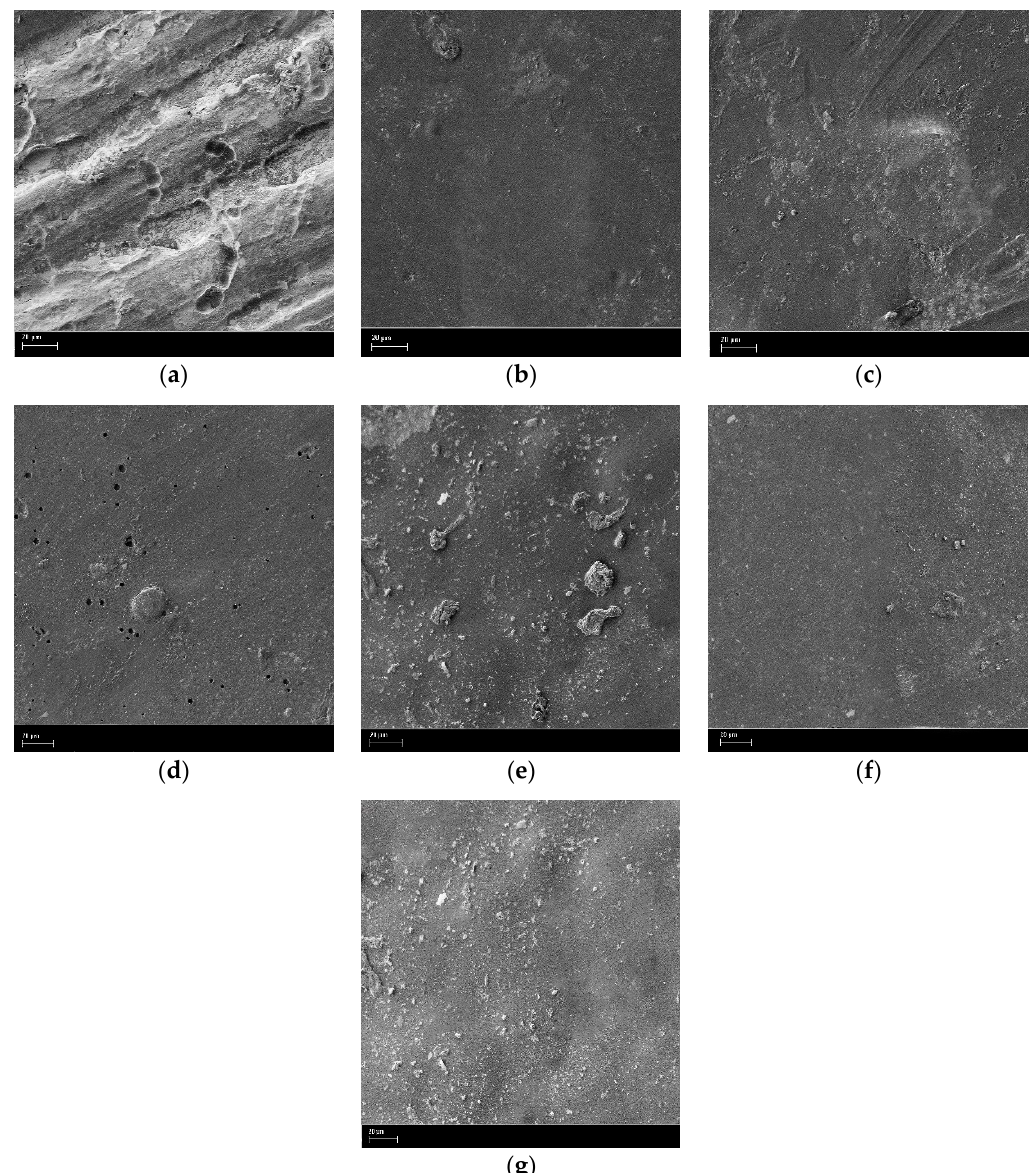
Figure 6. SEM images of the film surface of PMP-Br ( a ) and quaternized samples: 1 ( b ), 2 ( c ), 3 ( d ), 4 ( e ), 5 ( f ), and 6 ( g ).